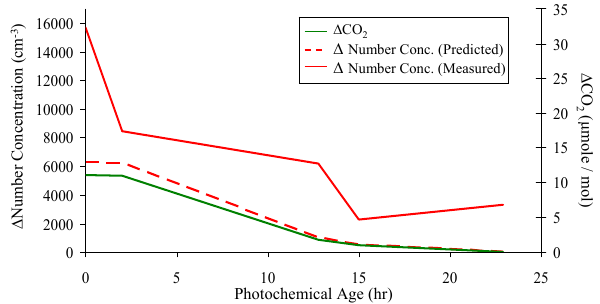
Figure 10. Comparison of the measured particle number concentration (red), calculated baseline number concentration (green), and number concentration with background and anticipated primary number concentration from the emission factor of this work (dashed red). Measurements of CO 2 and particle number concentration were obtained on March 11, 2006 aboard the NASA DC-8 flight which transected the Mexico City plume (14:15- 14:30 CST). The emission factor used to predict the increase in particle number is 568 particles cm -3 (µmole CO 2 /mol) -1 .